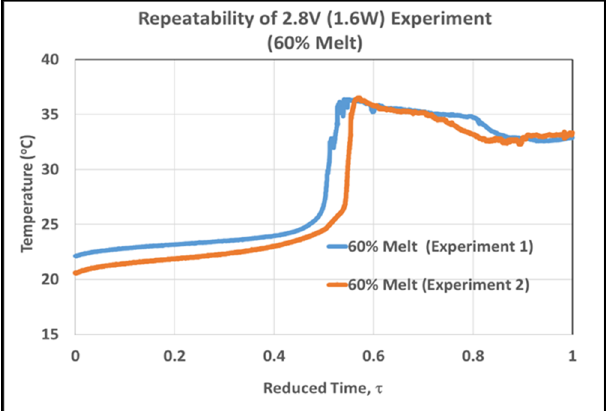
Figure 8. Comparison of temperature profiles in two different experiments for verifying the repeat- ability of the experiments: for the thermocouples mounted at the location corresponding to the height of the liquid meniscus for PCM melt-fraction of 30% and for heater input power of 1.6 W (2.8 V input).